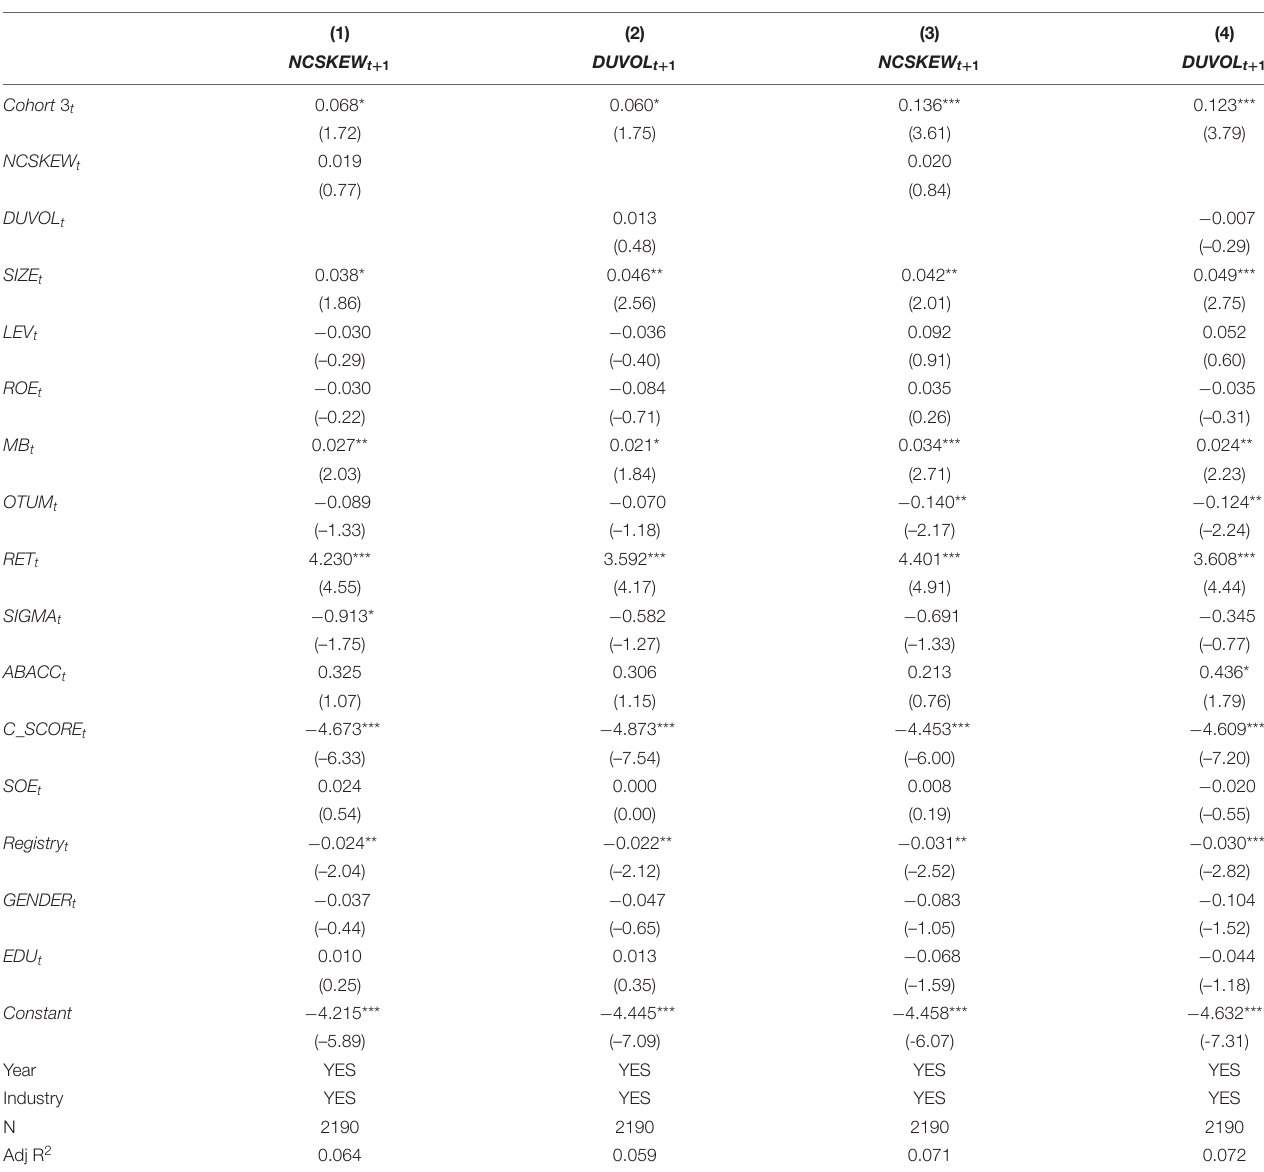
TABLE 12 | Robustness check: Propensity score